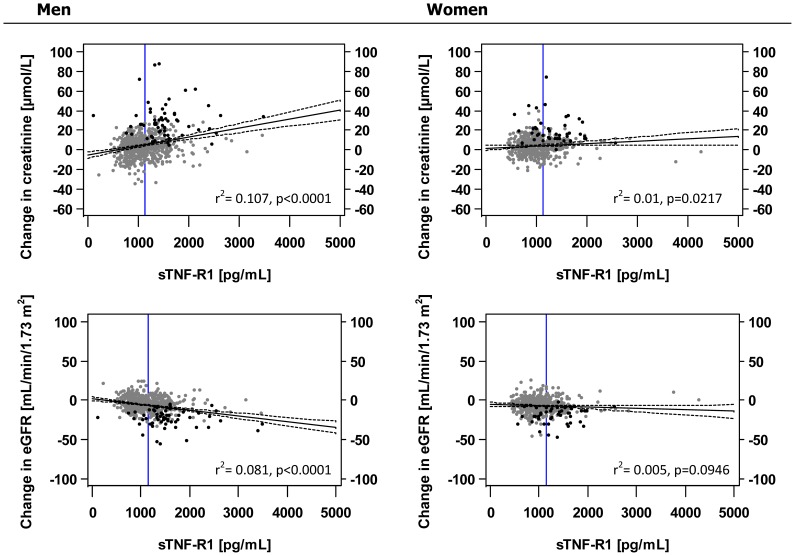
sTNF-R1 and change in eGFR/creatinine from baseline to follow-up.Black line: regression line with corresponding 95% (dashed line); vertical blue line: optimal cut off; black dots: subjects with eGFR<60 mL/min/1.73 m2 at follow-up; grey dots: subjects with eGFR>60 mil/min at follow-up. Abbreviations: sTNF-R1: Soluble tumour necrosis factor-α receptor 1, eGFR: estimated glomerular filtration rate.